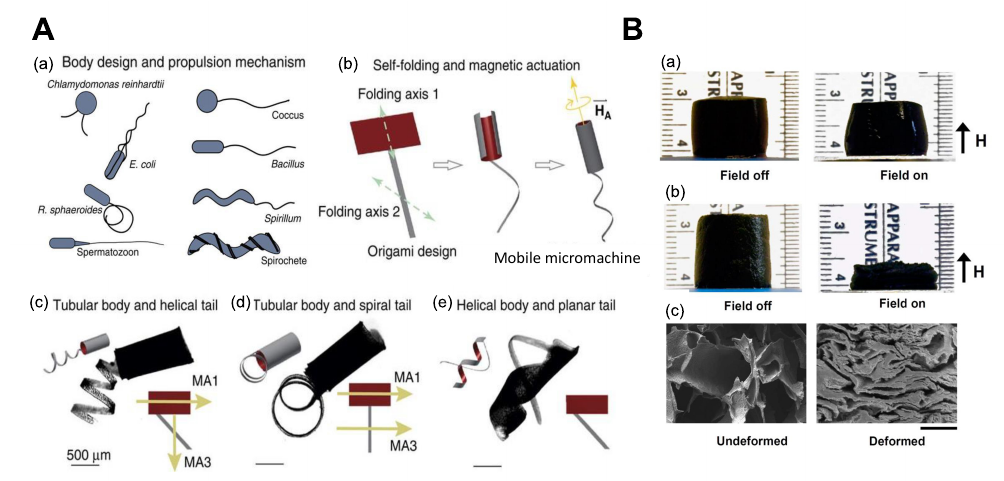
Figure 5. Magneto-responsive hydrogel-based actuators. ( A ) Reconfigurable body plans for soft hydrogel-based micromachines inspired by microorganisms. ( a ) A variety of hydrogel-based body designs and propeller mechanisms. ( b ) Anisotropic swelling behavior controlled by the alignment of magnetic nanoparticles (MNPs) along prescribed three-dimensional (3D) pathways and selective patterning of supporting layers results in 3D functional micromachines. The folding axes 1 and 2 denote the direction of folding for each compartment. The micromachine possesses multiple different magnetic axes, which determine the motility when the magnetic field (MF) is applied. The flagellated micromachine, which contains self-assembled MNPs, performs controllable swimming in the 3D space under a homogeneous rotating MF. ( c – e ) Optical images of flagellated soft micromachines with complex body plans. Magnetic axis (MA1 and MA3) denote the magnetic axes in the head and tail, respectively. Scale bars: 500 µ m. ( B ) The active hydrogel scaffold undergoes a large deformation and volume change via a moderate MF. ( a ) A cylinder of nanoporous hydrogel was reduced by nearly 5% of its height when subjected to a vertical MF gradient of 38 Am − 2 . ( b ) The corresponding macroporous hydrogel deformed by nearly 70% under the same MF. ( c ) Scanning electron microscopy (SEM) images of a free-dried macroporous hydrogel in the undeformed and deformed states. Scale bar: 500 µ